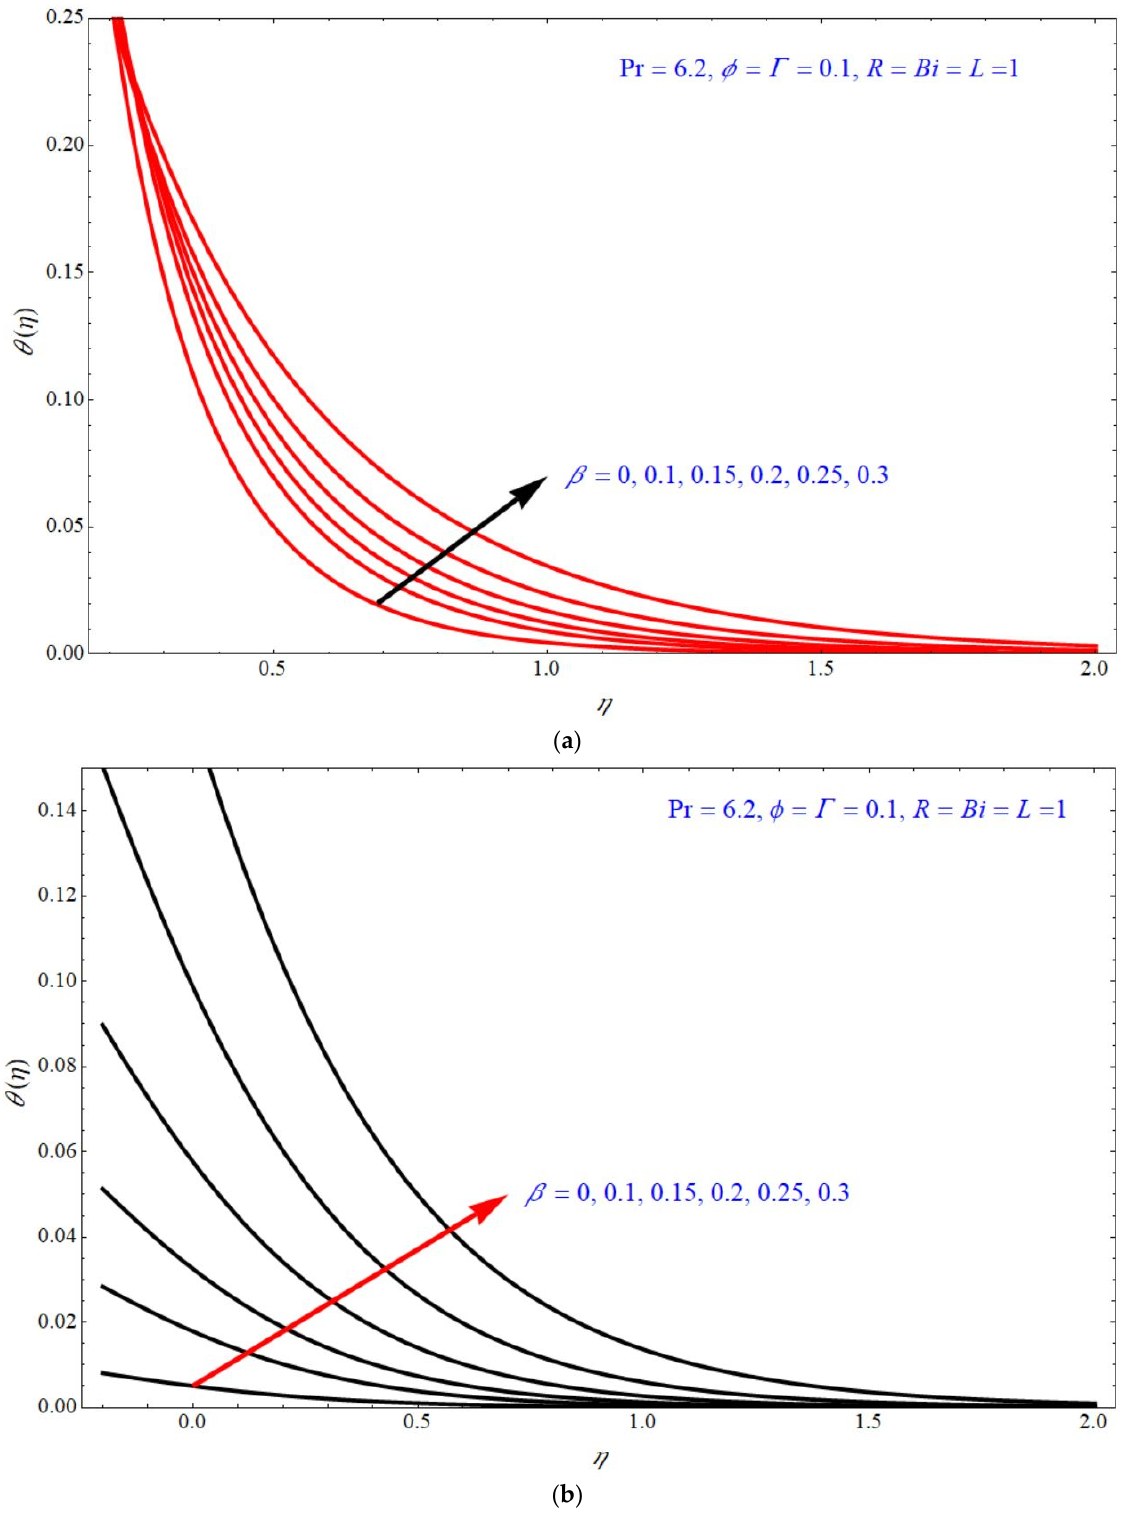
( ) θ η β η = = − Figure 7. Impact of on for various choices of at ( a ) 1 d and ( b ) 1 d . Figure 7. Impact of θ ( η ) on η for various choices of β at ( a ) d = 1 and ( b ) d = − 1. Figure 8a,b depict the impact of mass transpiration V C on solid volume fraction φ for various values of Γ . Domain V C moves towards negative values if we increase the values of Γ for both stretching and shrinking cases. Here, it seems to be that the shrinking case is wider than the stretching